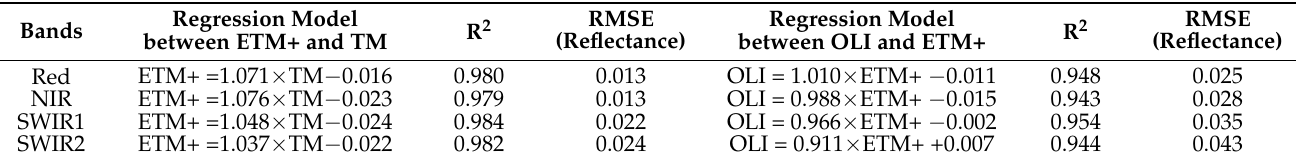
Table 2. The correction coefficients of ETM+, TM and